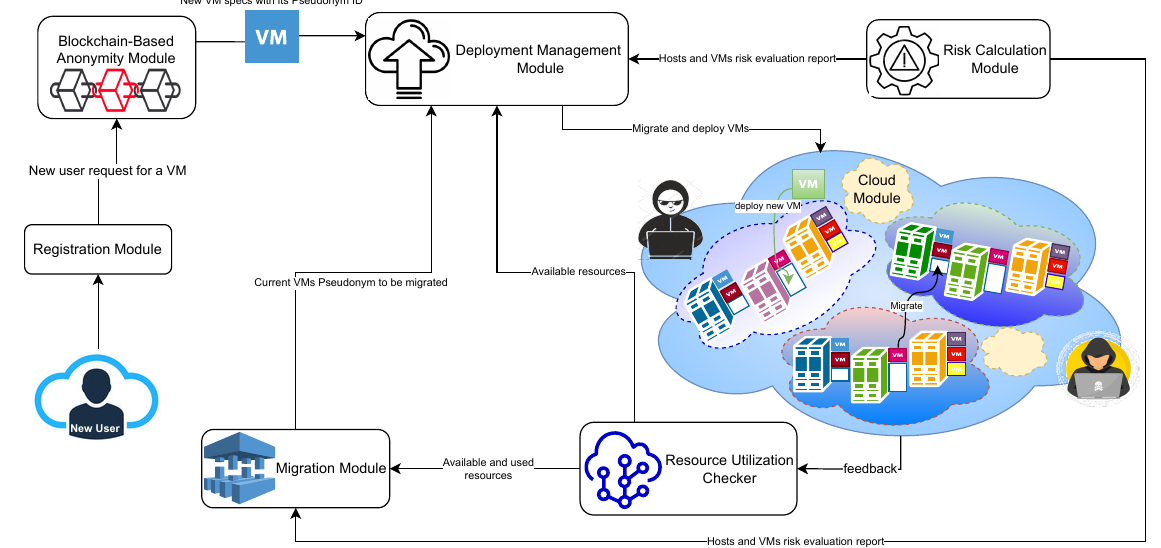
Figure 3. System